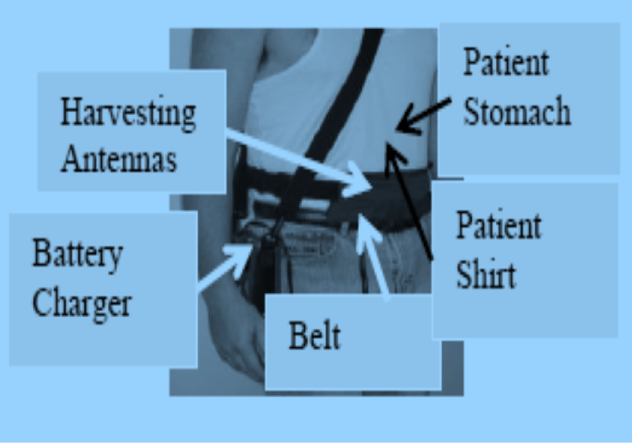
Figure 31. Wearable RF Medical Sensors with Energy Harvesting unit for IoT, 5G, and Healthcare Applications.